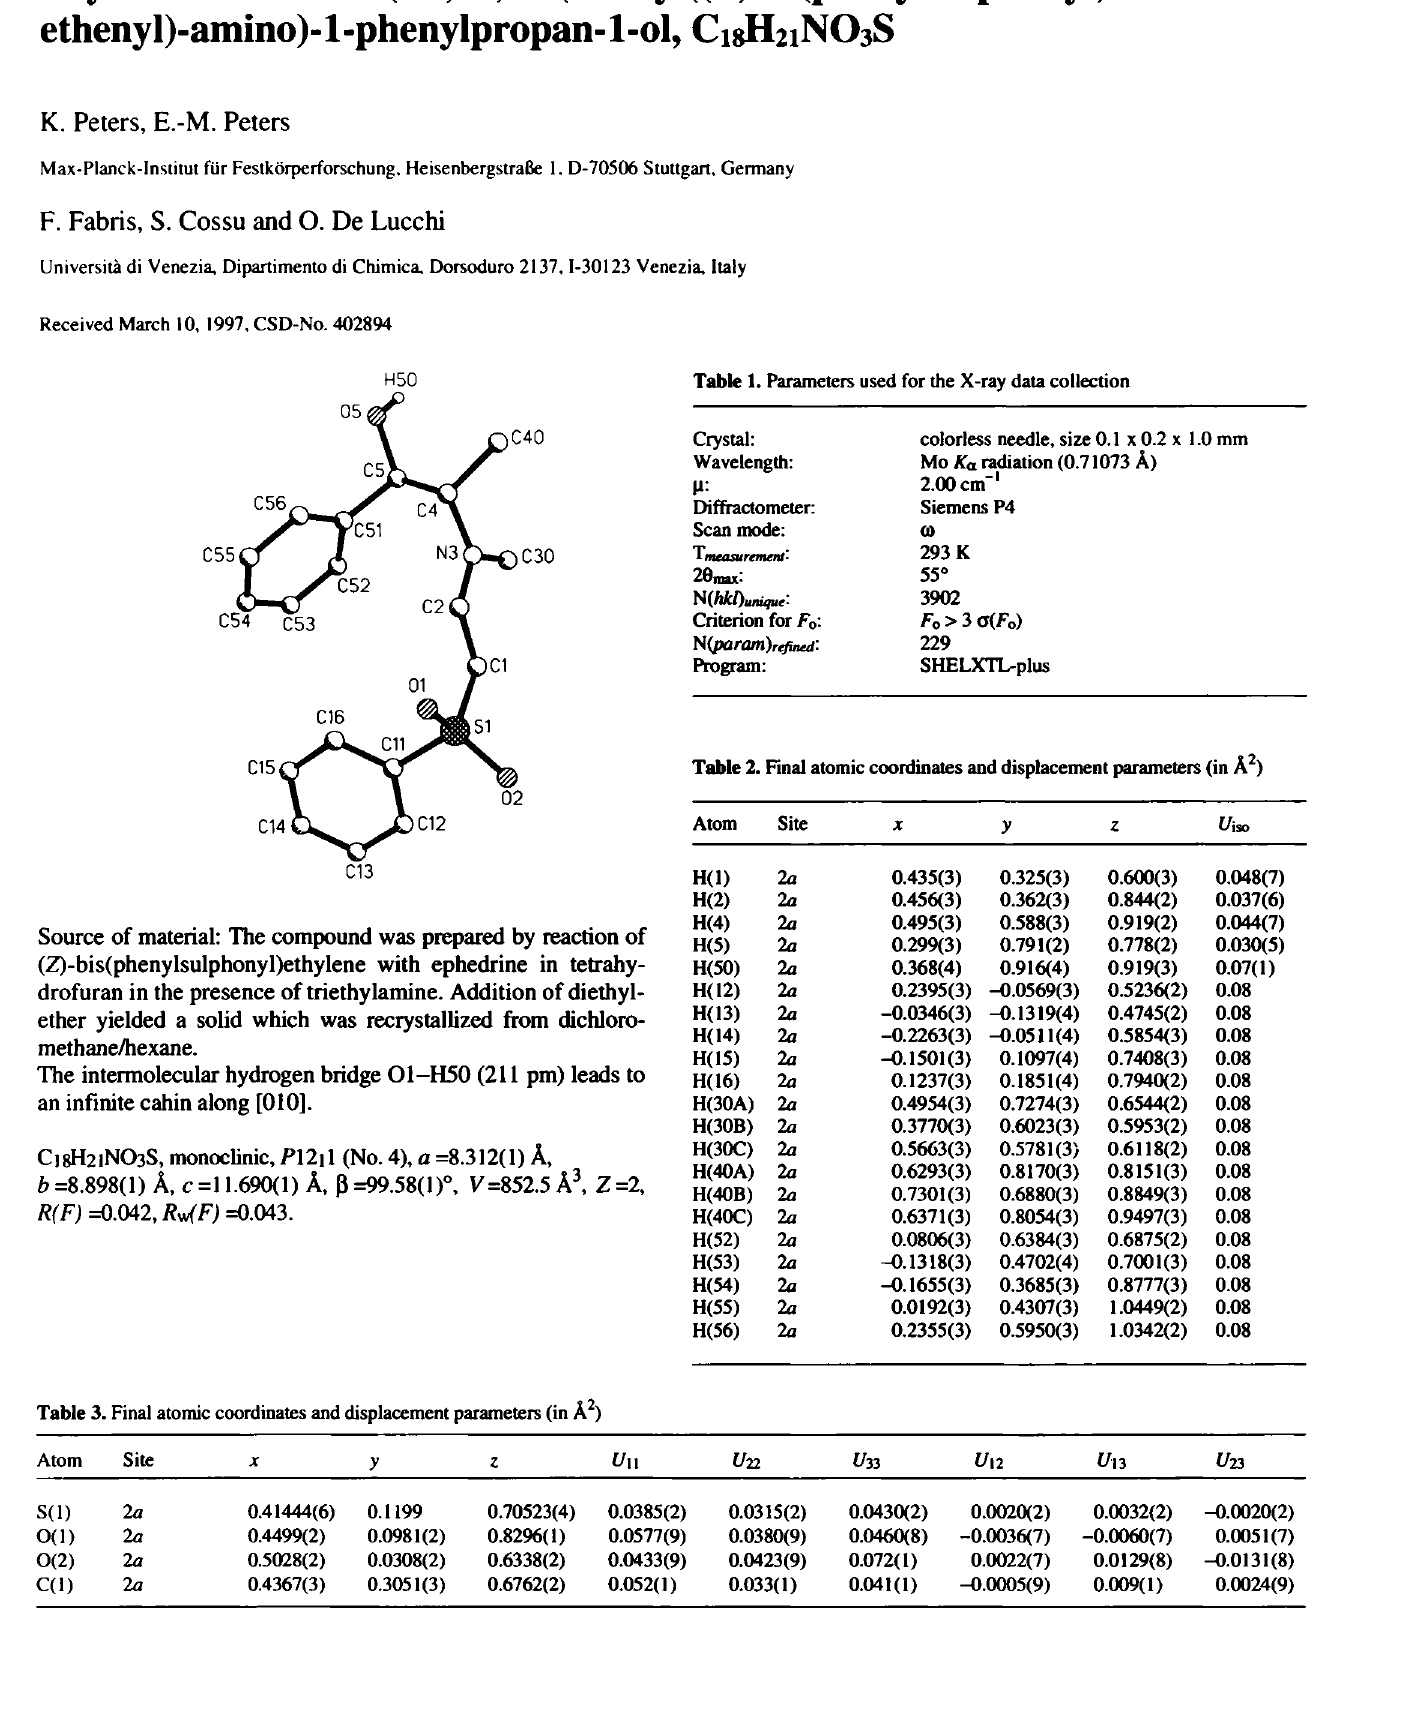
Table 1. Parameters used for the X-ray data collection Crystal: